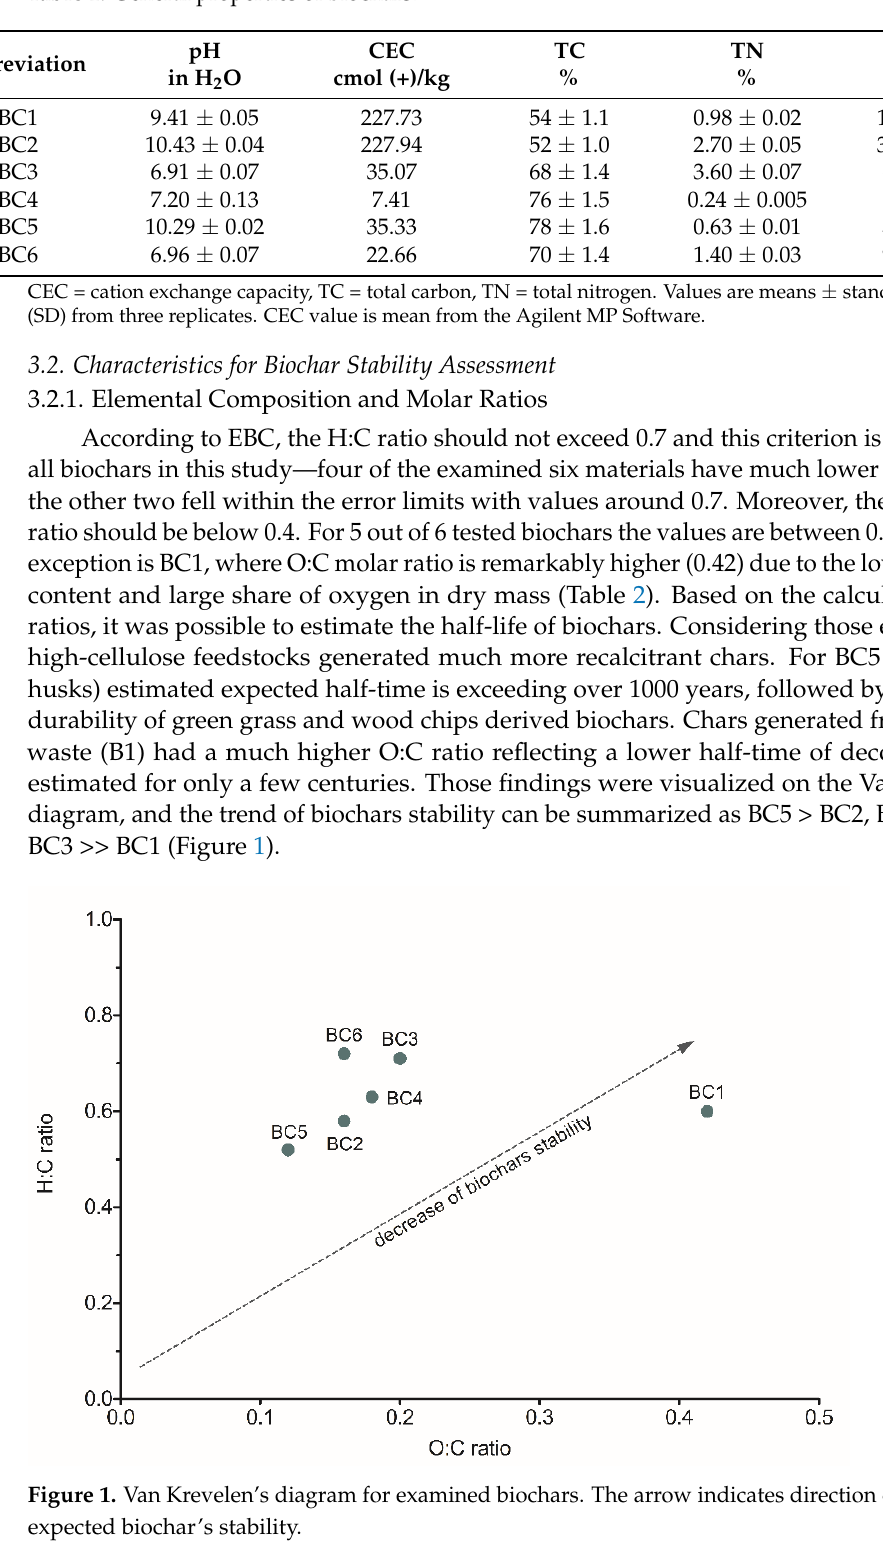
Table 1. General properties of biochars.